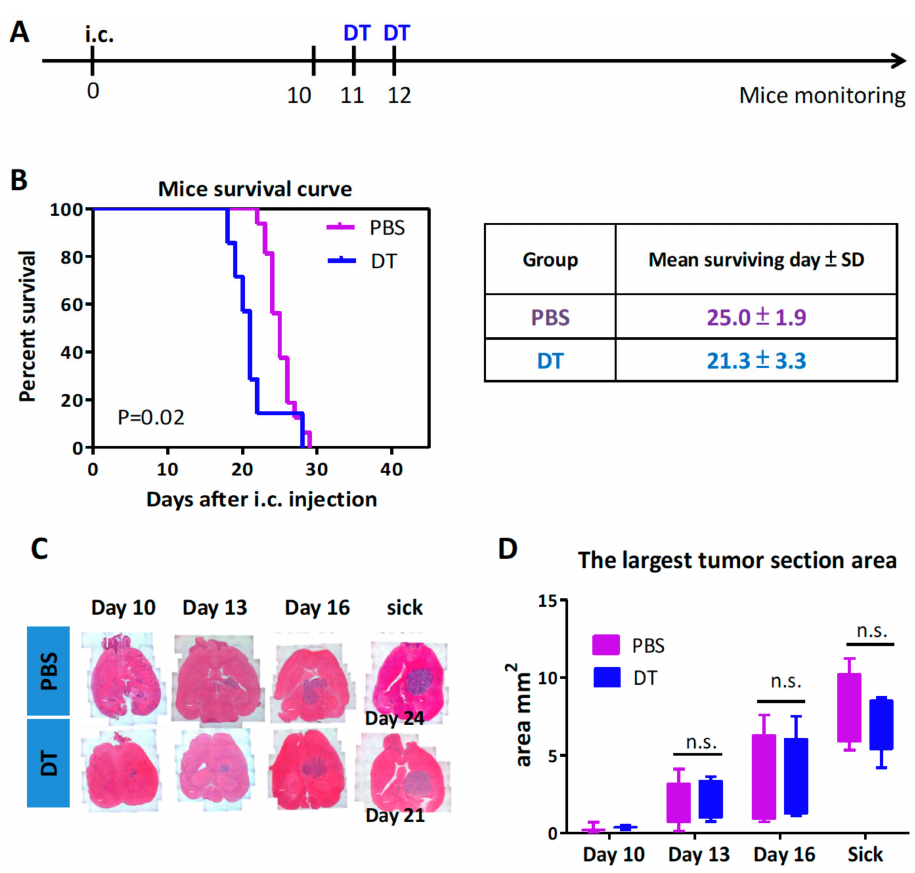
Figure 2. Depletion of CD11b + Ly6G − Ly6C − MDCs alone did not impede tumor growth. ( A )